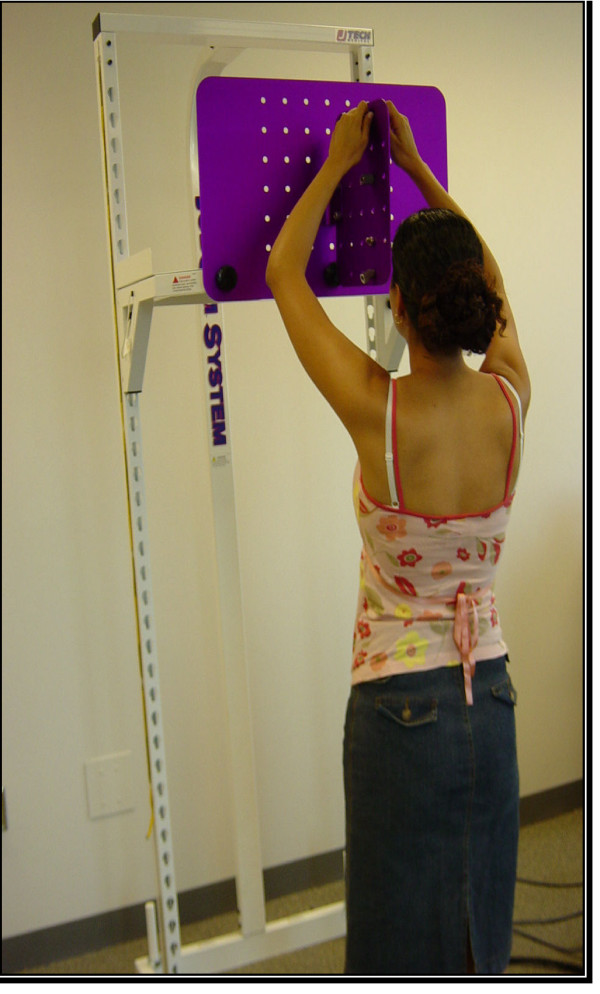
Task 3, "Overhead Work".